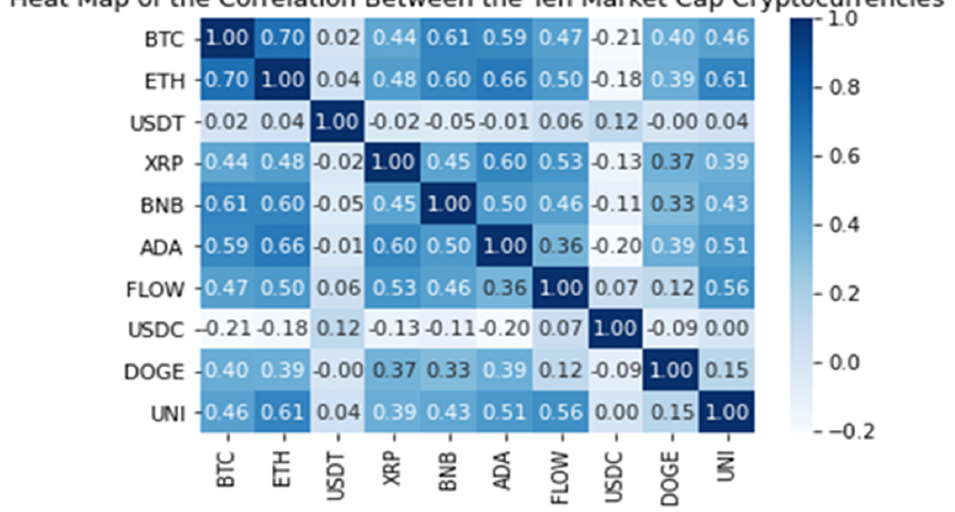
Figure 3. Correlation plot of price returns of 10 cryptocurrencies based on market